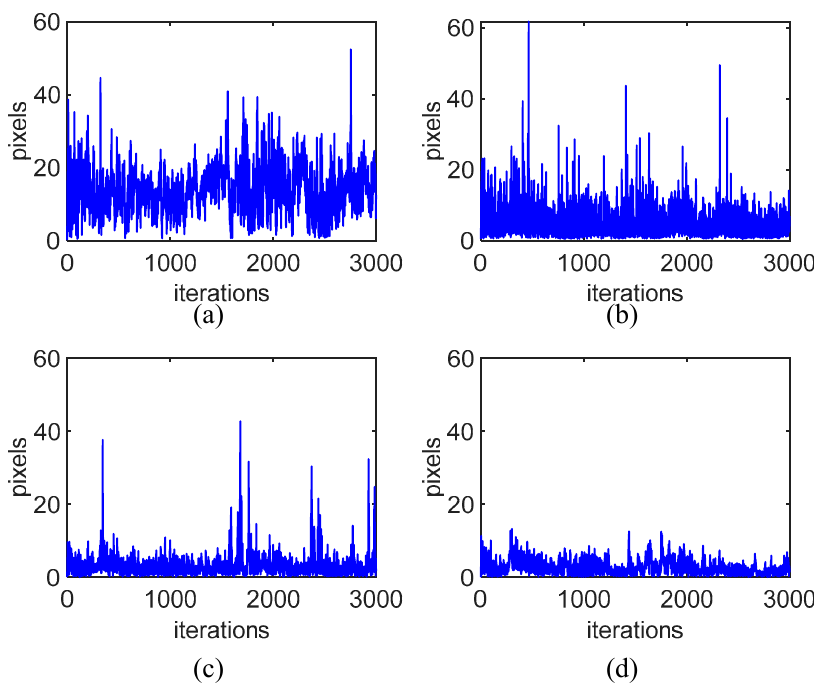
Figure 7. Image error of different strategies in a triple leaf rose path. ( a ) Image error of IBUVS. ( b ) Image error of the original PHUVS. ( c ) Image error of the improved PHUVS with the KF method. ( d ) Image error of the improved PHUVS with the KF-SVSF method.